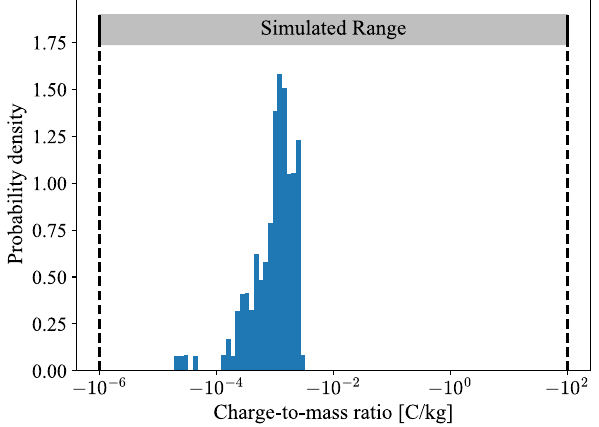
FIG. 16. Histogram showing the most likely charge-to-mass ratios as determined from the MC simulations. A concentration is found around − 1 . 20 × 10 − 3 C = kg for this particular event.